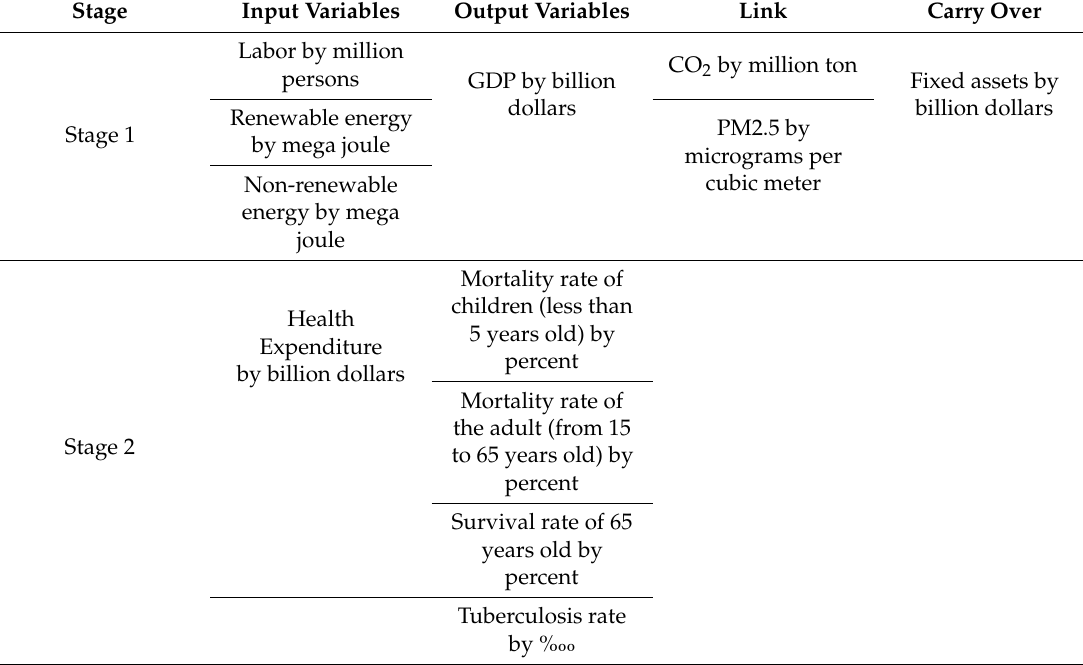
Table 2. Input and output